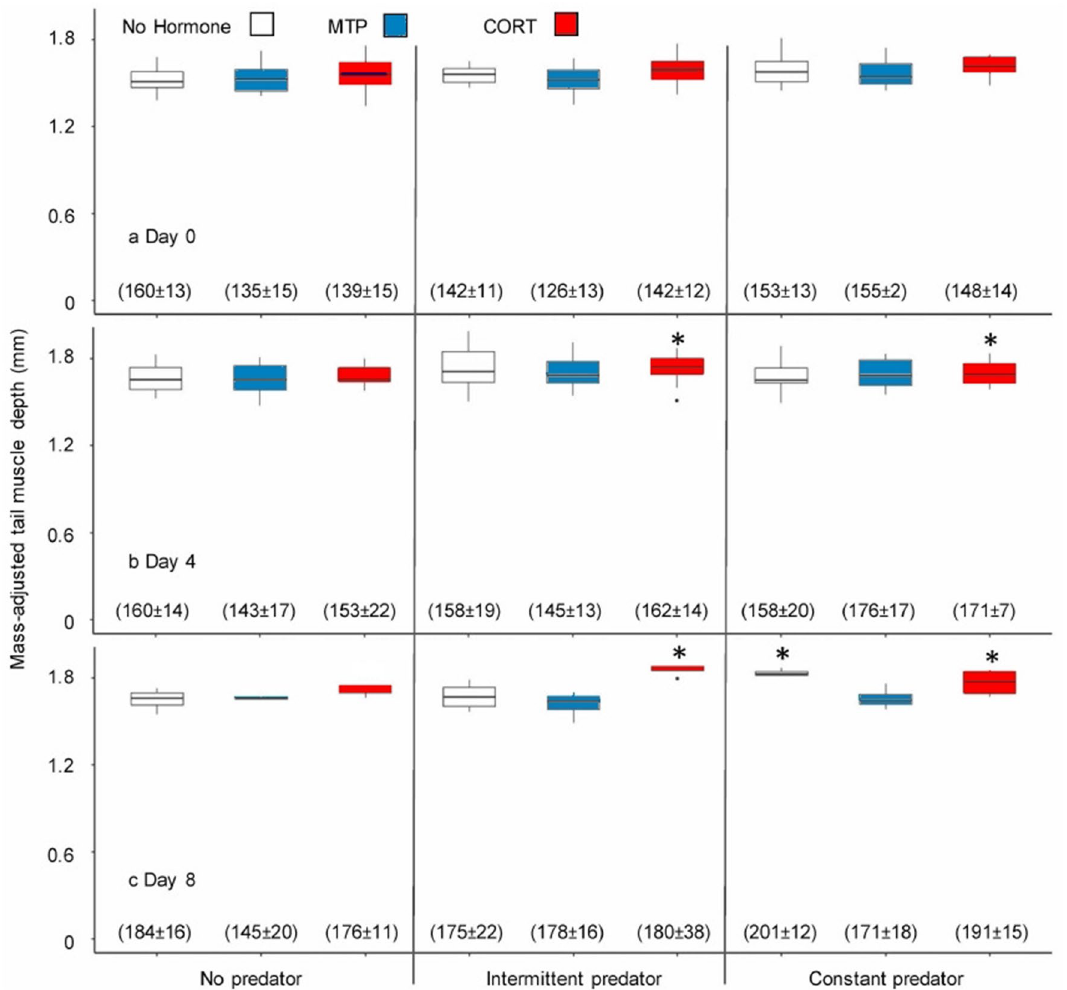
Figure 1. Treatment of wood frog tadpoles with corticosterone (CORT) or nonlethal exposure to a predator increased tail muscle depth, while treatment with the corticosteroid synthesis inhibitor metyrapone (MTP) blocked the tail muscle response to the predator. Shown are boxplots (median and interquartile range) of mass- adjusted tail muscle depth in each treatment combination ( n = 4 replicates) on Day 0 ( a ), Day 4 ( b ), and Day 8 ( c ). Mean individual tadpole mass (± s.e.m.) is given below each box. Asterisks indicate statistically significant differences compared to the No predator/No hormone treatment (Bonferroni-corrected P < 0.05). Other statistically significant pairwise contrasts are given in Supplementary Table